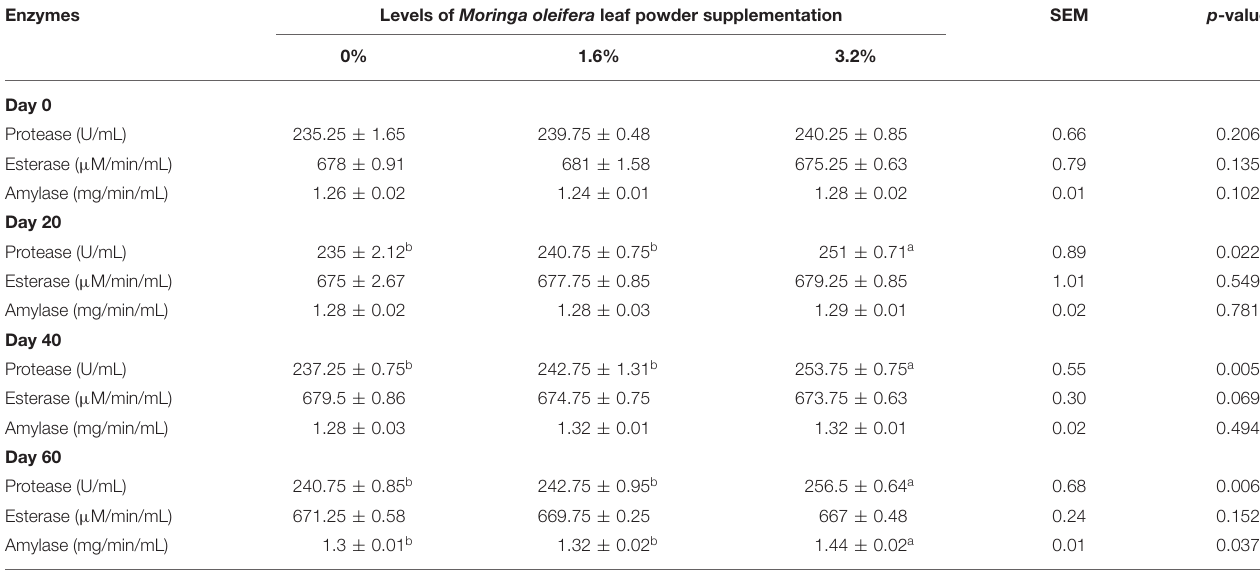
TABLE 8 | Plasma hydrolytic enzyme activities of pregnant beetal goats. Enzymes Levels of Moringa oleifera leaf powder